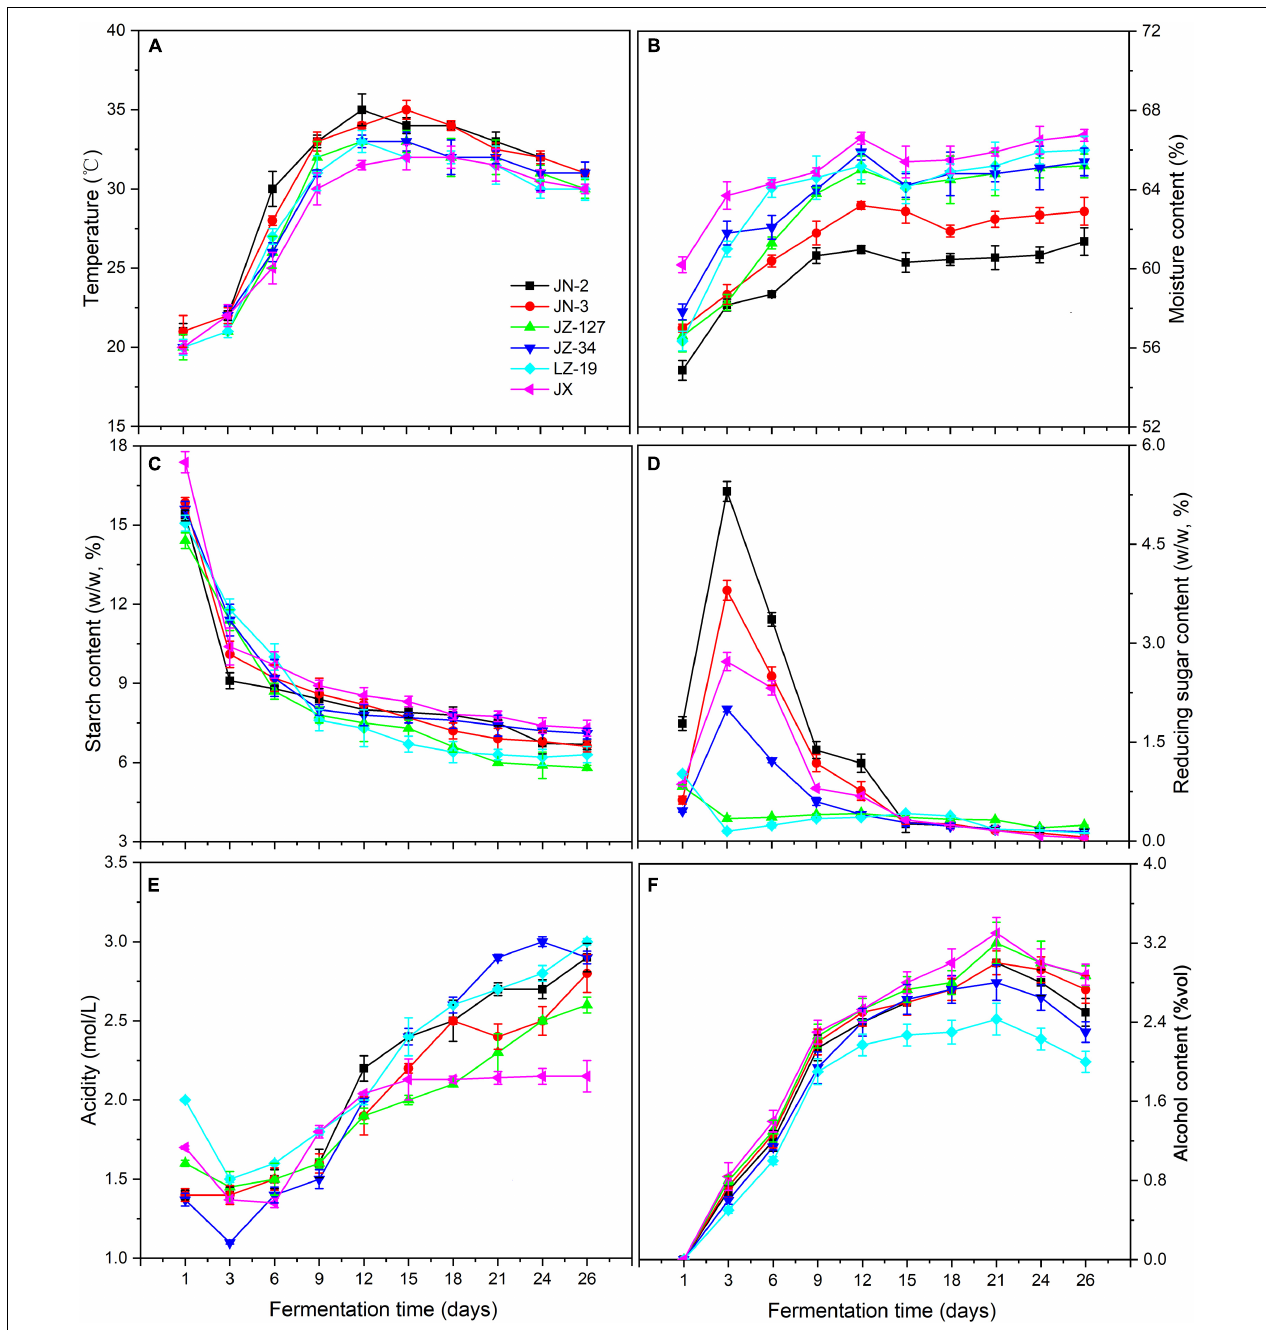
FIGURE 2 | Changes in temperature (A) , moisture content (B) , starch content (C) , reducing sugar content (D) , acidity (E) , and alcohol content (F) of fermented grains during fermentation in two waxy (JN-2 and JN-3) and four non-waxy sorghum varieties (JZ-127, JZ-34, LZ-19, and JX).